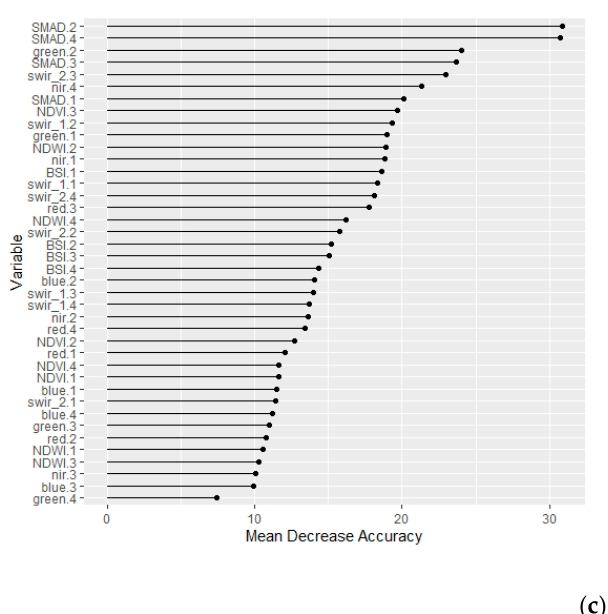
Figure 5. Variable importance expressed as mean decrease in accuracy for the stacked quarter datasets where the digit following each variable represents the quarter (1= January–March, 2 = April–June, 3 = July–September, 4 = October–December) for ( a ) Silalatshani, ( b ) Nabusenga, and ( c ) Lungwalala.